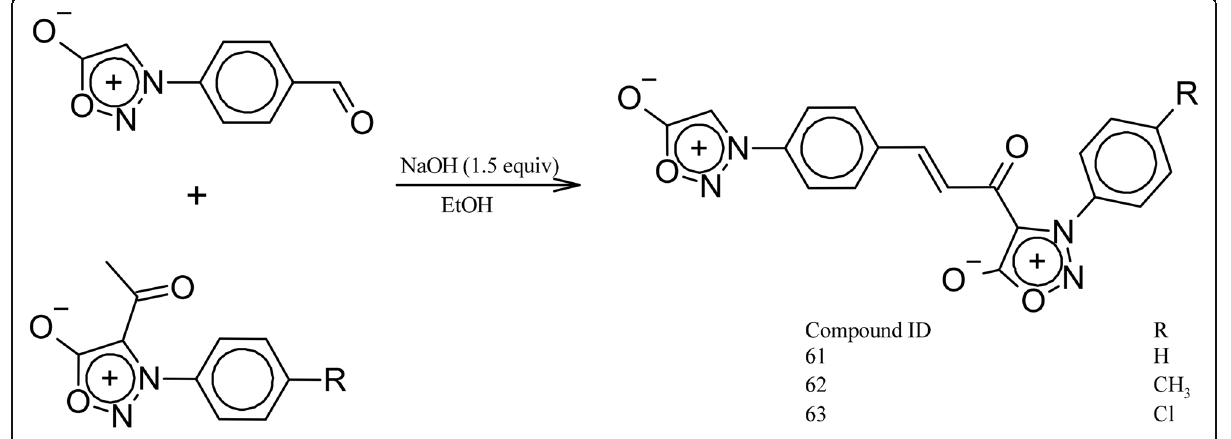
Fig. 4 Synthesis of bis -sydnone styryl ketone 61 –